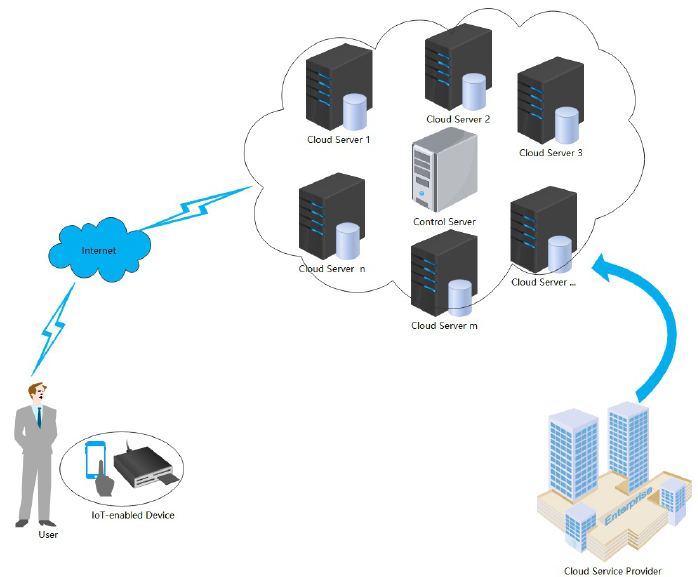
Figure 1. Architecture of IoT-enabled cloud